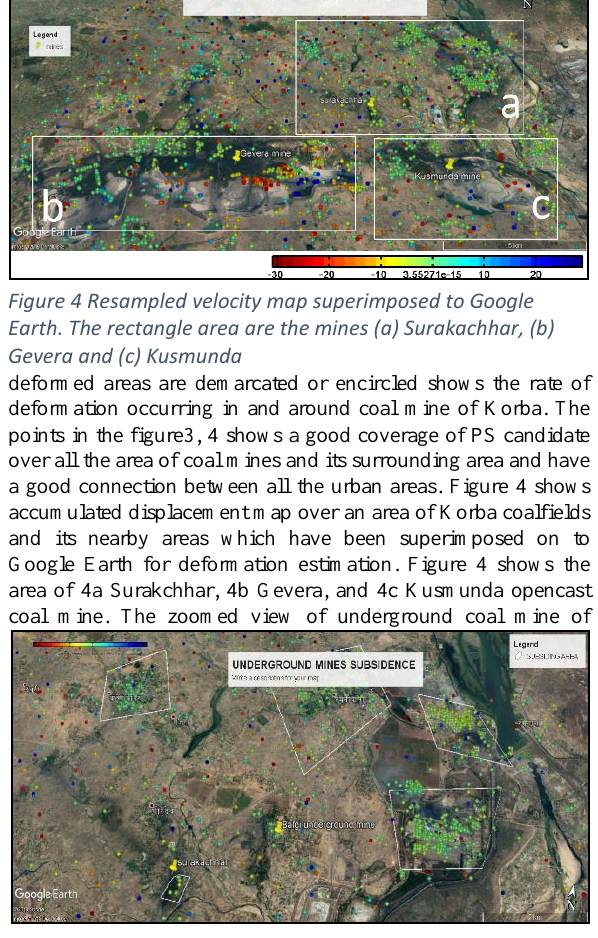
Figure 5 Zoomed view of in and around underground mine